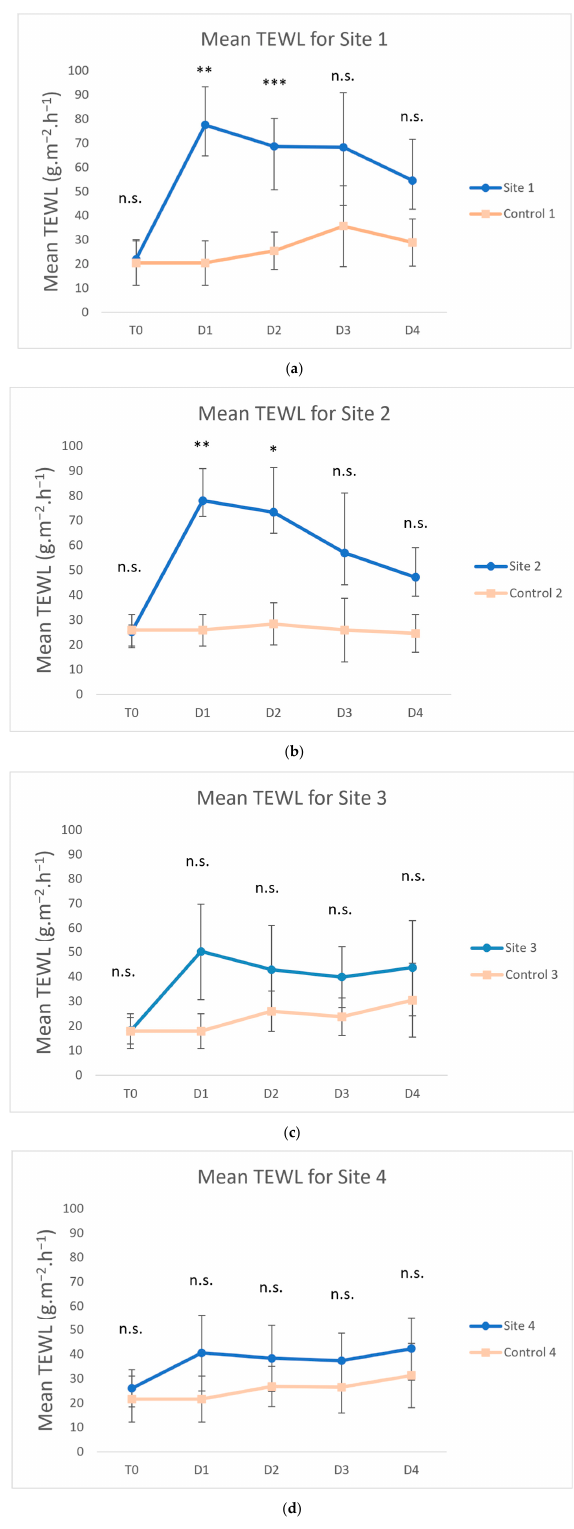
Figure 2. Means and standard deviations of transepidermal water loss (TEWL) for Site 1 (Week 1) ( a ), Site 2 (Week 2) ( b ), Site 3 (Week 3) ( c ) and Site 4 (Week 4) ( d ). Days were labeled as T0 (before tape stripping), D1 (one hour after tape stripping), D2 (24 h after tape stripping), D3 (48 h after tape stripping) and D4 (72 h after tape stripping). The values increased for test sites after tape stripping and decreased towards control values on the following days (*** p < 0.001; ** p < 0.01; * p < 0.05; n.s., not significantly different from control).